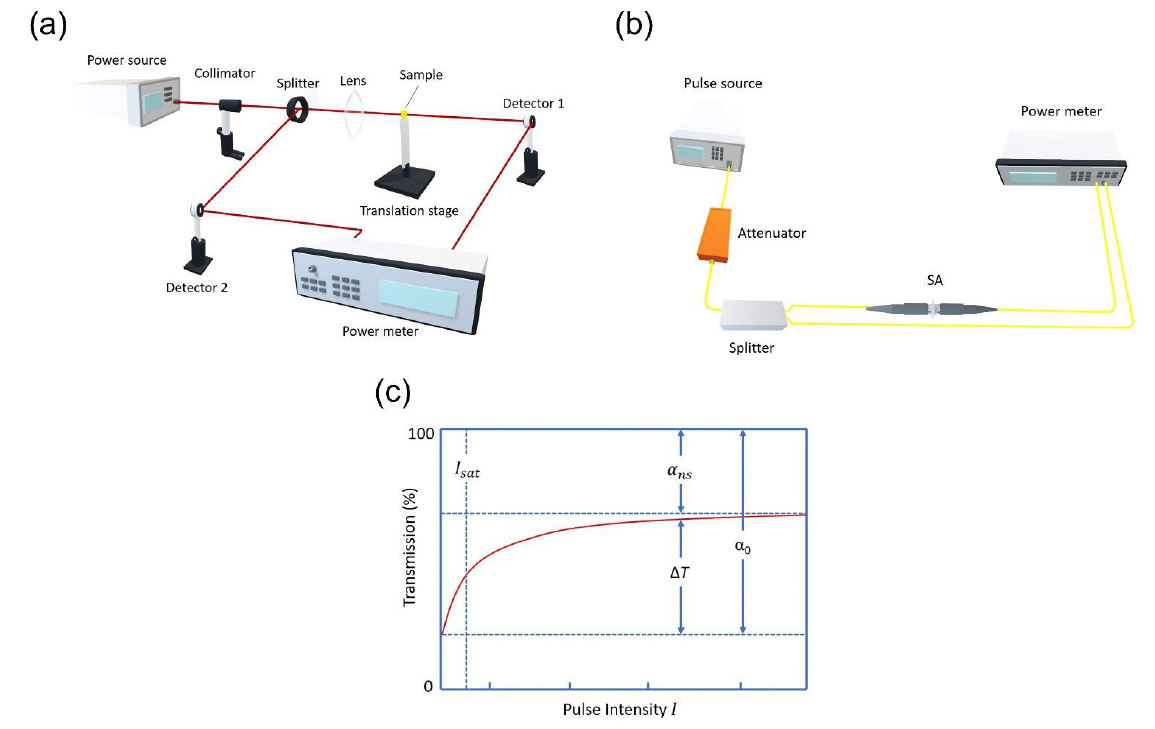
Figure 14. ( a ) Z-scan measurement ( b ) I-scan measurement (or balanced twin-detector technique) ( c ) Example of a trans- mission curve.